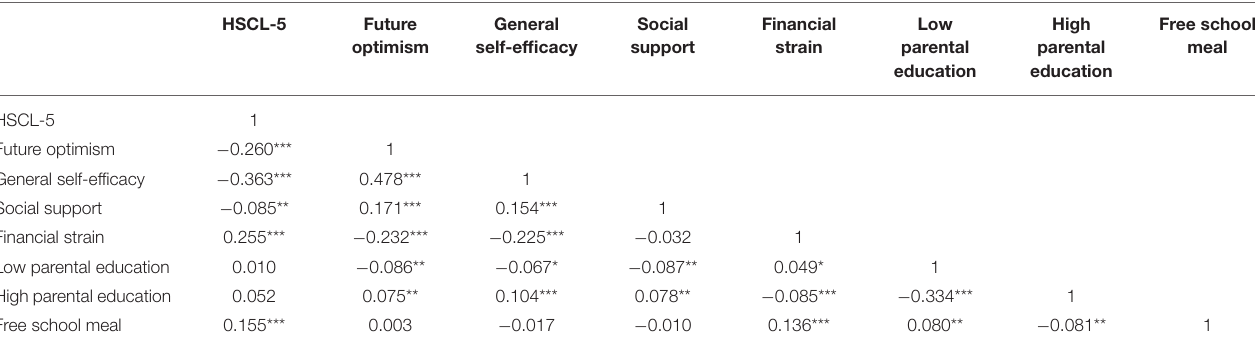
TABLE 1 | Correlation table for the model variables SES, financial strain, psychosocial resource factors and mental distress ( N = 2,402).